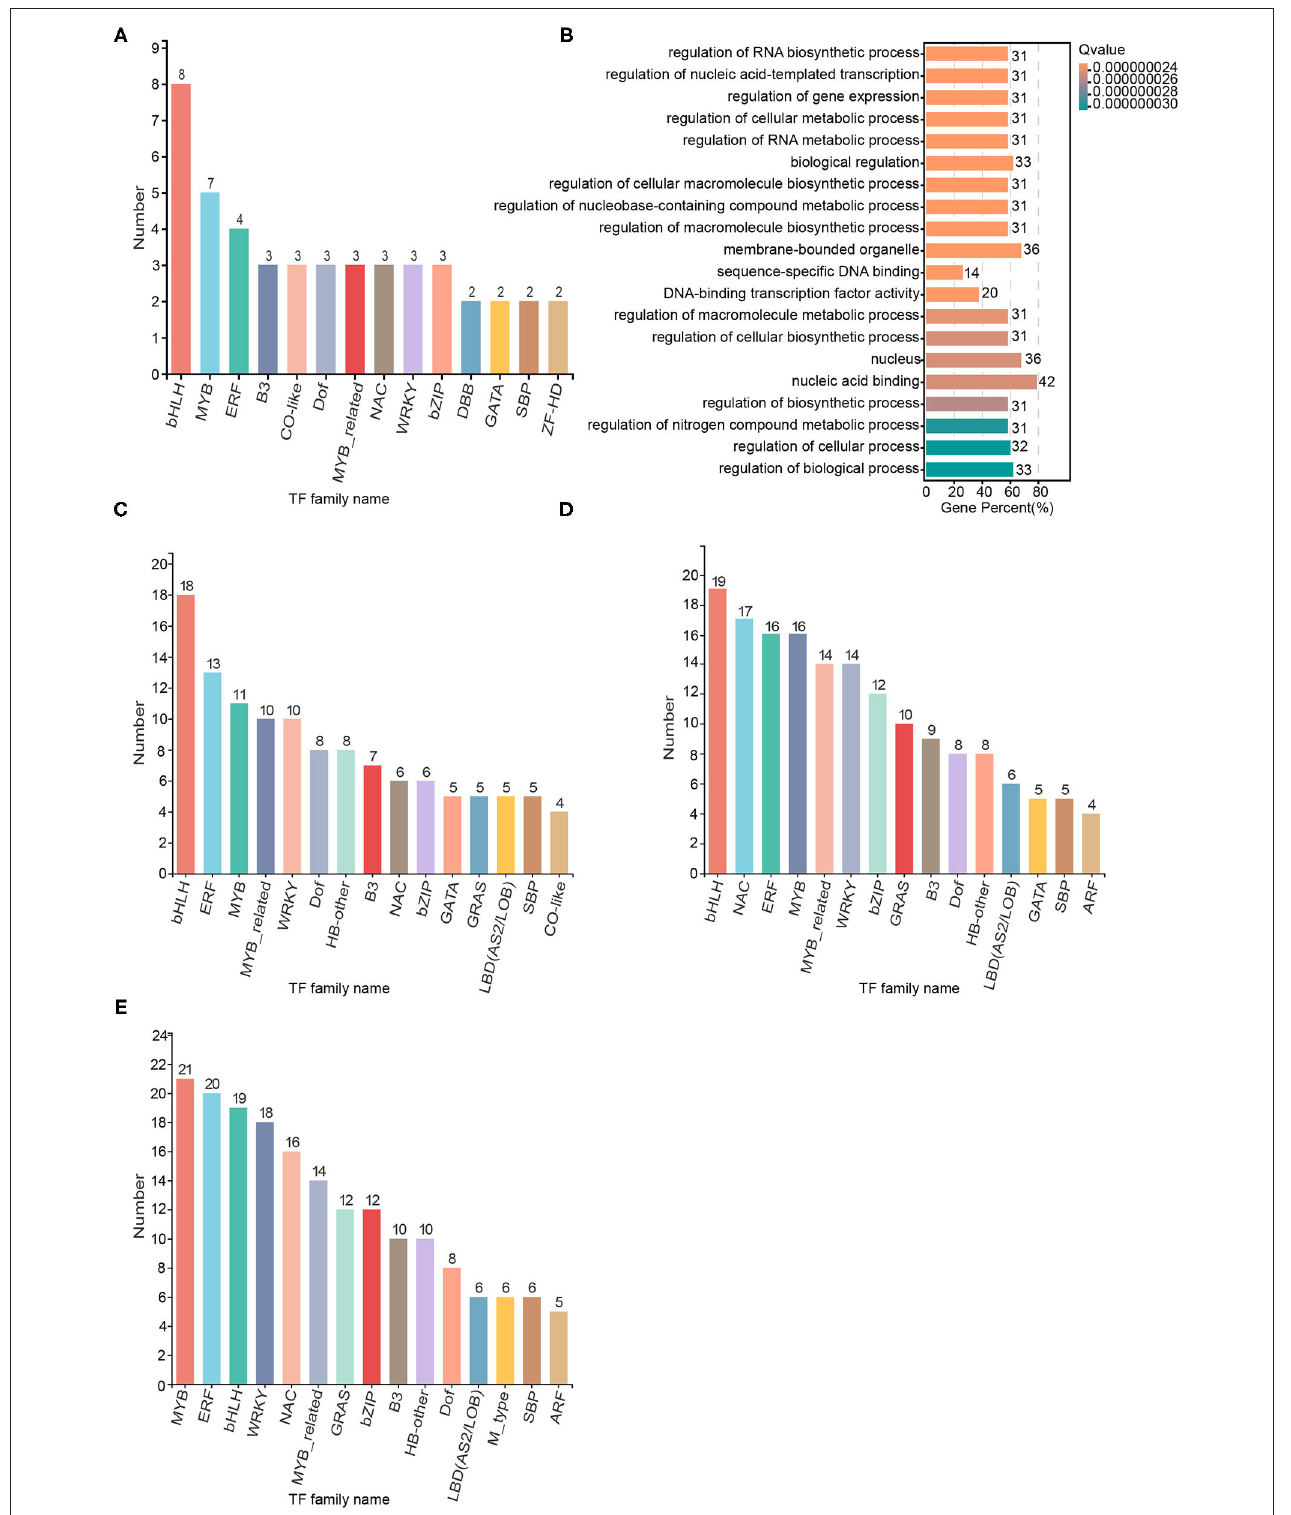
FIGURE 7 | Transcription factor families of the senescence-associated genes (SAGs) on day 2, 4, and 6 shared by the darkness and salt treatments. Significantly enriched transcription factor families were identified by Hmmscan E -value (1.0E-5) and Blast E -value (1.0E-5). (A) The transcription factor families from 1546 darkness and salt treatment SAGs across three time points. (B) Scatter diagram of transcription factor families in (A) based on the Gene Ontology enrichment (GO) enrichment analysis. (C) Transcription factor families in the 3,001 darkness and salt treatment SAGs on day 2. (D) Transcription factor families in the 3,787 darkness and salt treatment SAGs on day 4. (E) Transcription factor families in the 4,419 darkness and salt treatment SAGs on day 6.